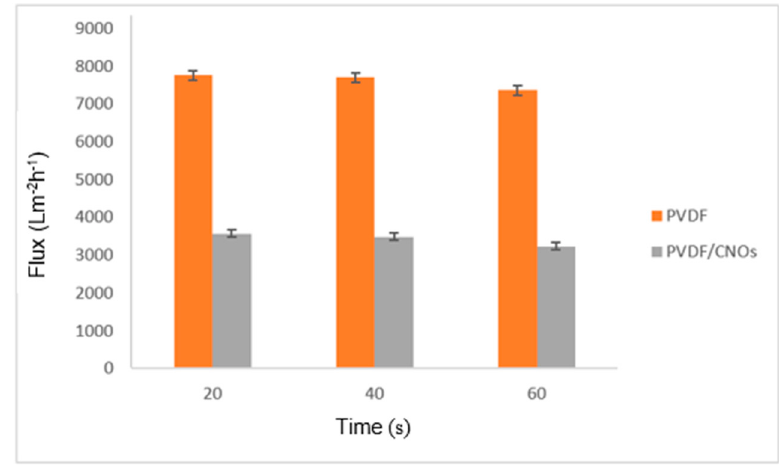
Figure 1. Pure water flux of PVDF and PVDF/CNOs.